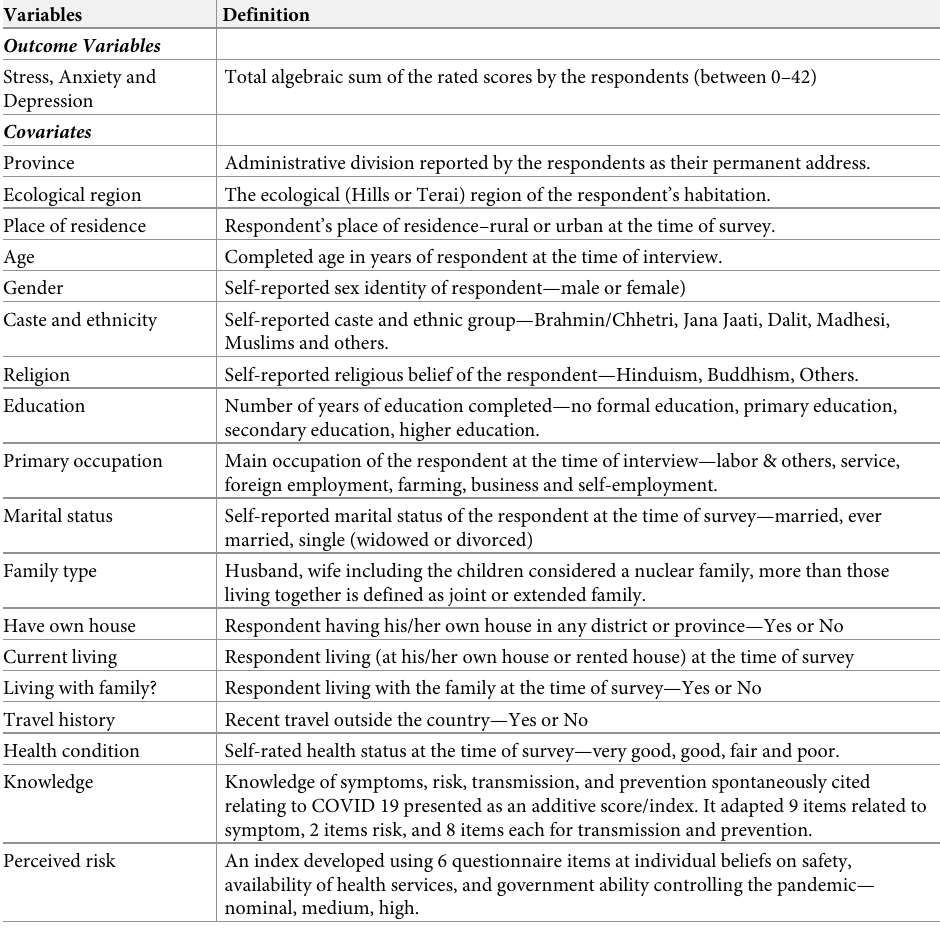
Table 2. Variables and their definitions used in the study.